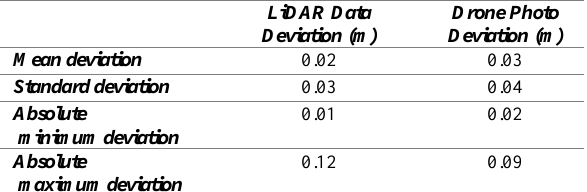
Table 2 . Planimetric evaluation in comparison with the GNSS reference survey